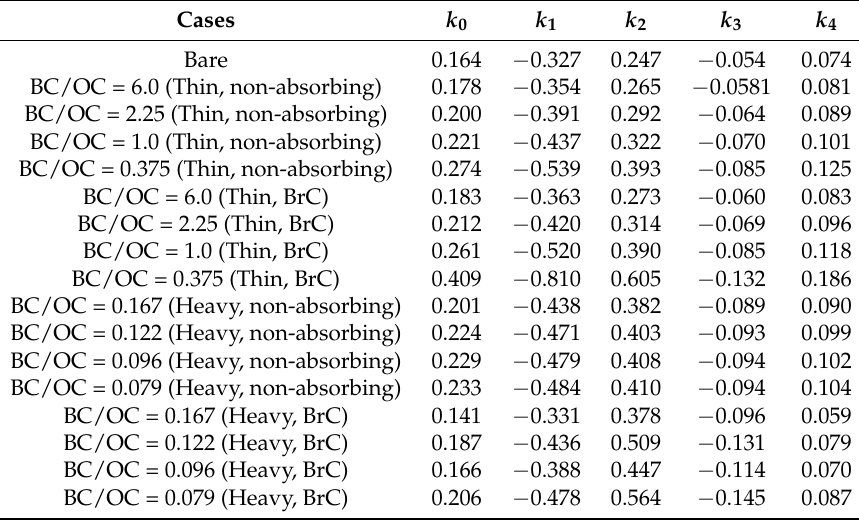
Table A4. Fitting parameters of BC aerosols for C abs (350